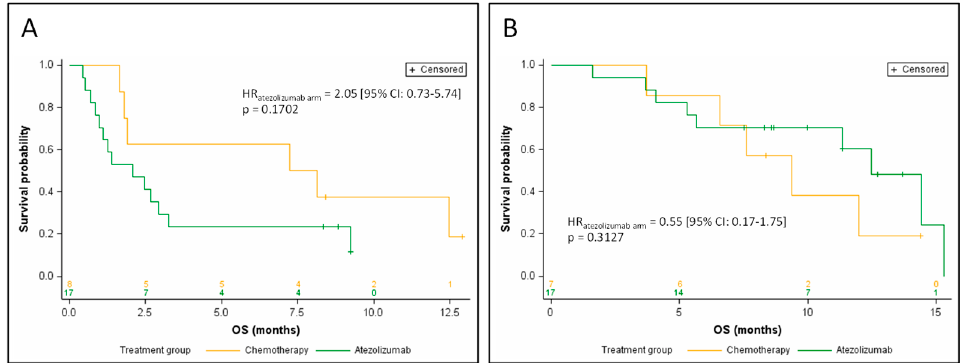
Figure 3. Kaplan–Meier estimates of overall survival, depending on the treatment arm, for patients with relative ctDNA abundance above the median ( A ), and for patients with relative ctDNA abundance below the median ( B ).